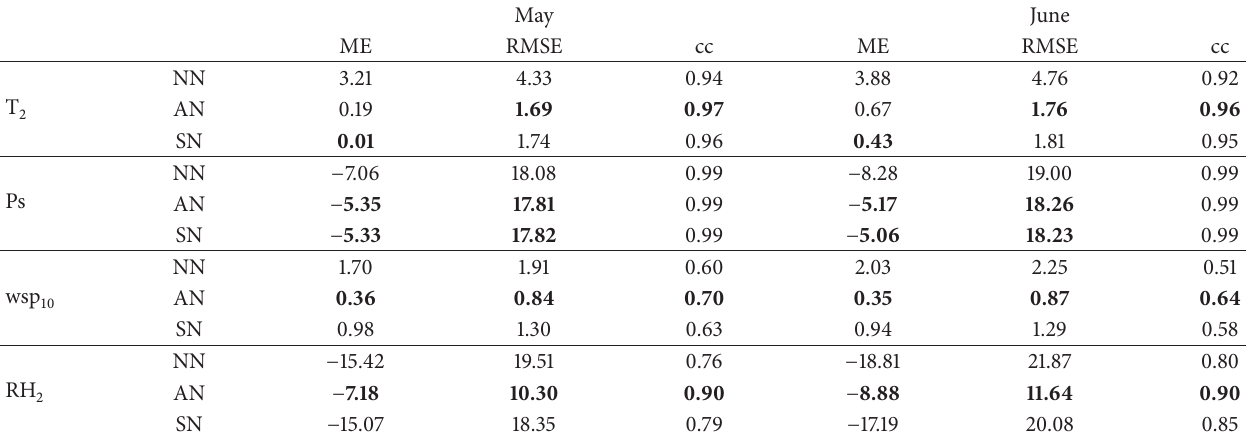
Table 2: Summary of the ME, RMSE, and cc for monthly averaged conventional meteorological elements near the surface, including the 2